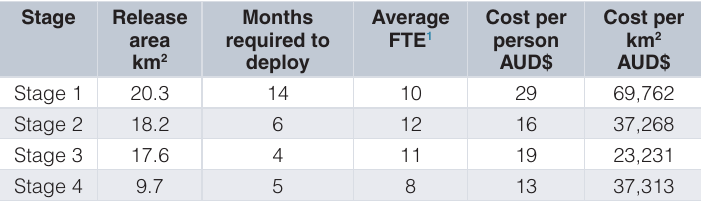
Table 3. Cost per person and cost per km 2 for each of the four release stages in Townsville.